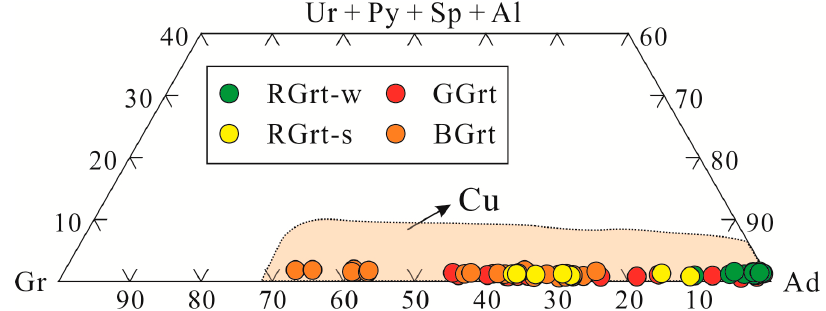
Figure 8. Major element compositions of the garnets showing the dominance of their end members. Colored areas indicate the garnet composition ranges for copper skarn deposits [63]. Abbreviations: Gr = grossular; Ad = andradite; Ur = uvarovite; Py = pyrope; Sp = spessartine; Al = almandine. RGrt-s = zone with stronger color intensity under BSE for dark red garnet; RGrt-w = zone with weaker color intensity under BSE for dark red garnet; GGrt = green garnet; and BGrt = light brown garnet.